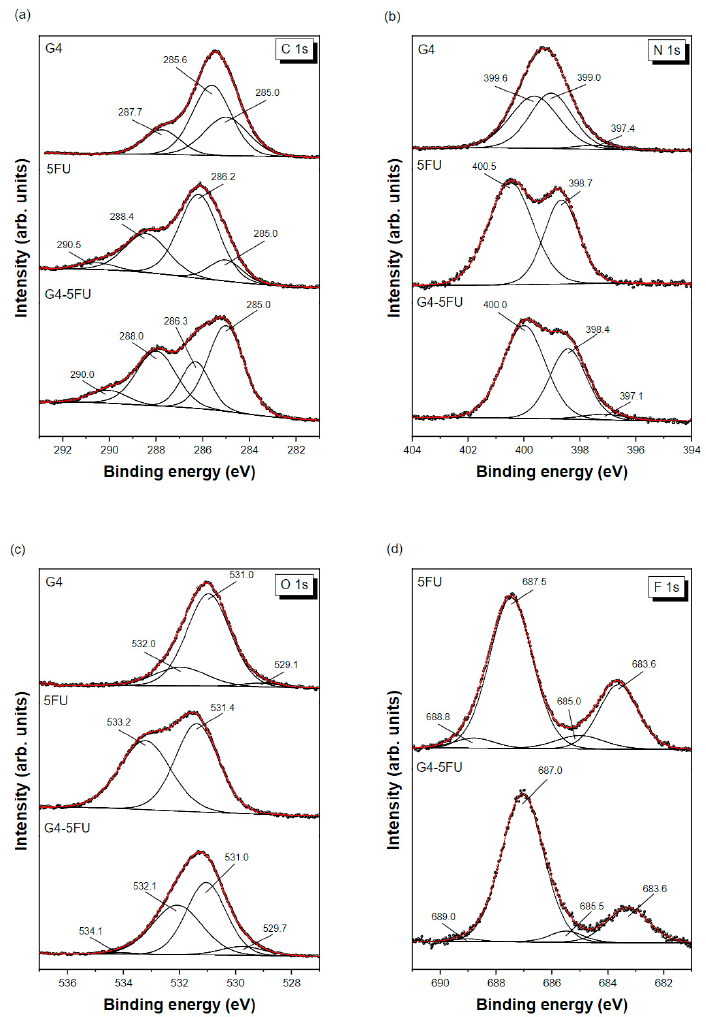
Figure 4. The XPS spectra of G4PAMAM dendrimer, 5-fluorouracil, and G4-5FU layers deposited on Au surface in the BE regions of C 1s ( a ), N 1s ( b ), O 1s ( c ), and F 1s ( d